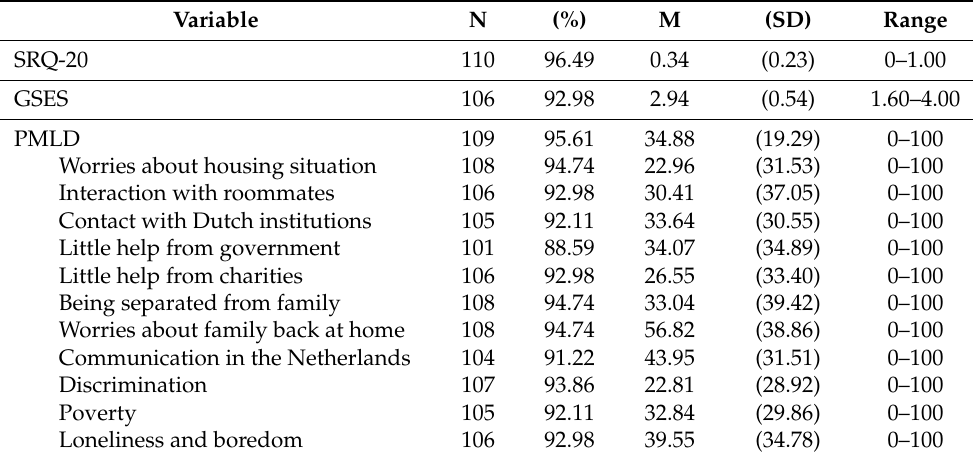
Table 2. Descriptives ( N = 114).